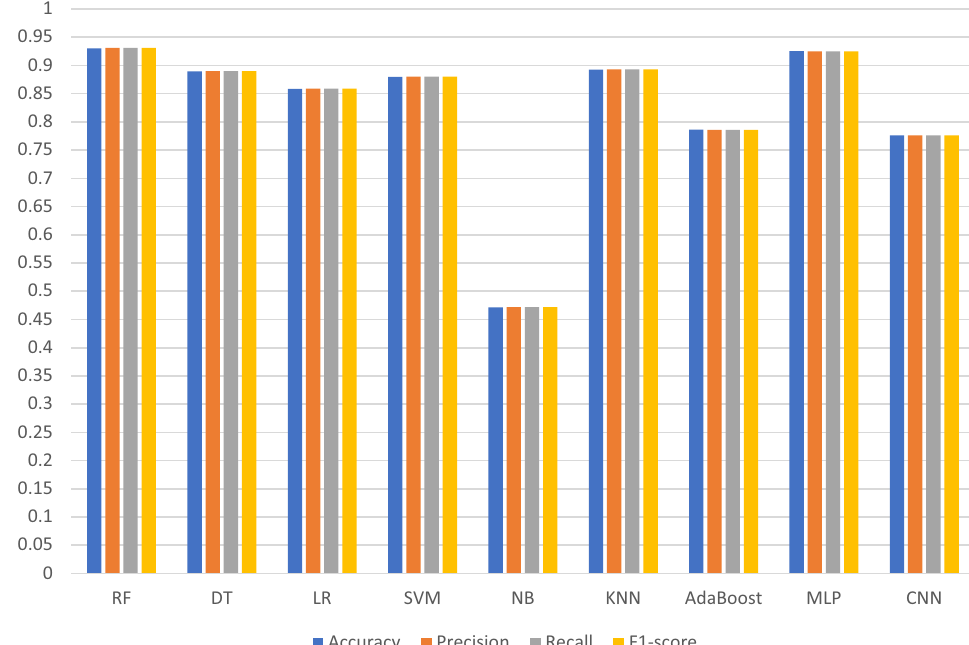
Fig. 6 Results with logarithmic